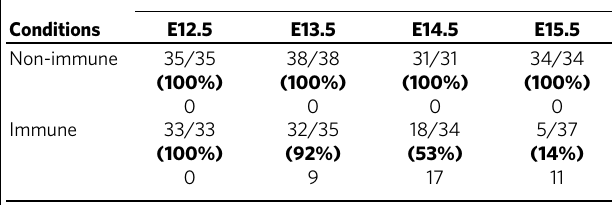
Table 1 Fetal survival decreases in FNAIT at